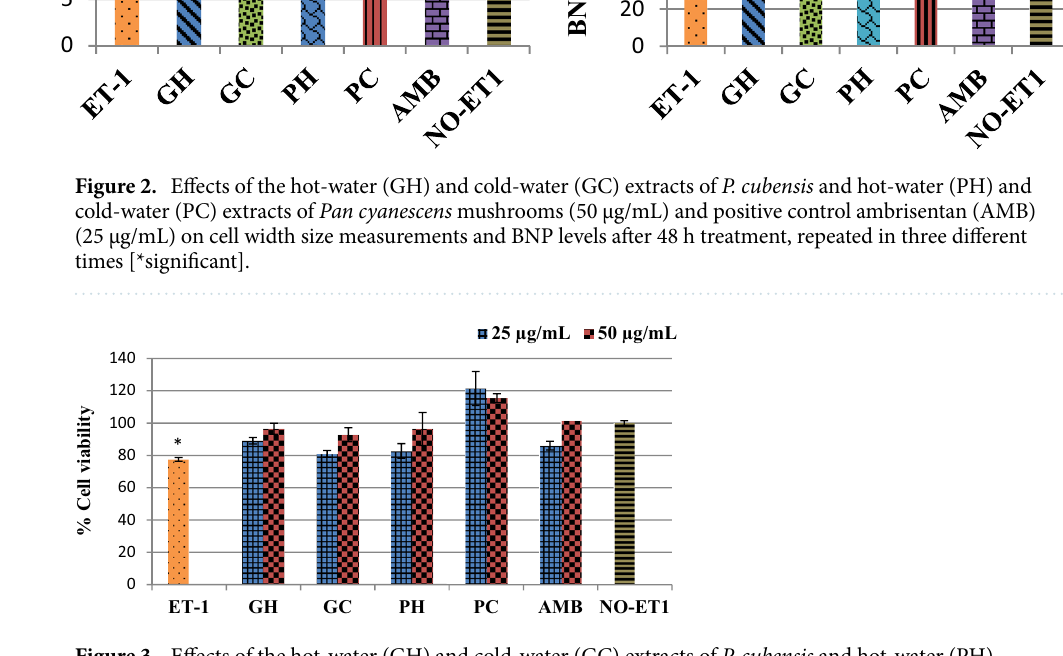
Figure 3. Effects of the hot-water (GH) and cold-water (GC) extracts of P. cubensis and hot-water (PH) and cold-water (PC) extracts of Pan cyanescens mushrooms (25 and 50 μg/mL) and positive control (AMB) ambrisentan (10 and 25 μg/mL) on % cell viability after 48 h treatment. Repeated in three different times